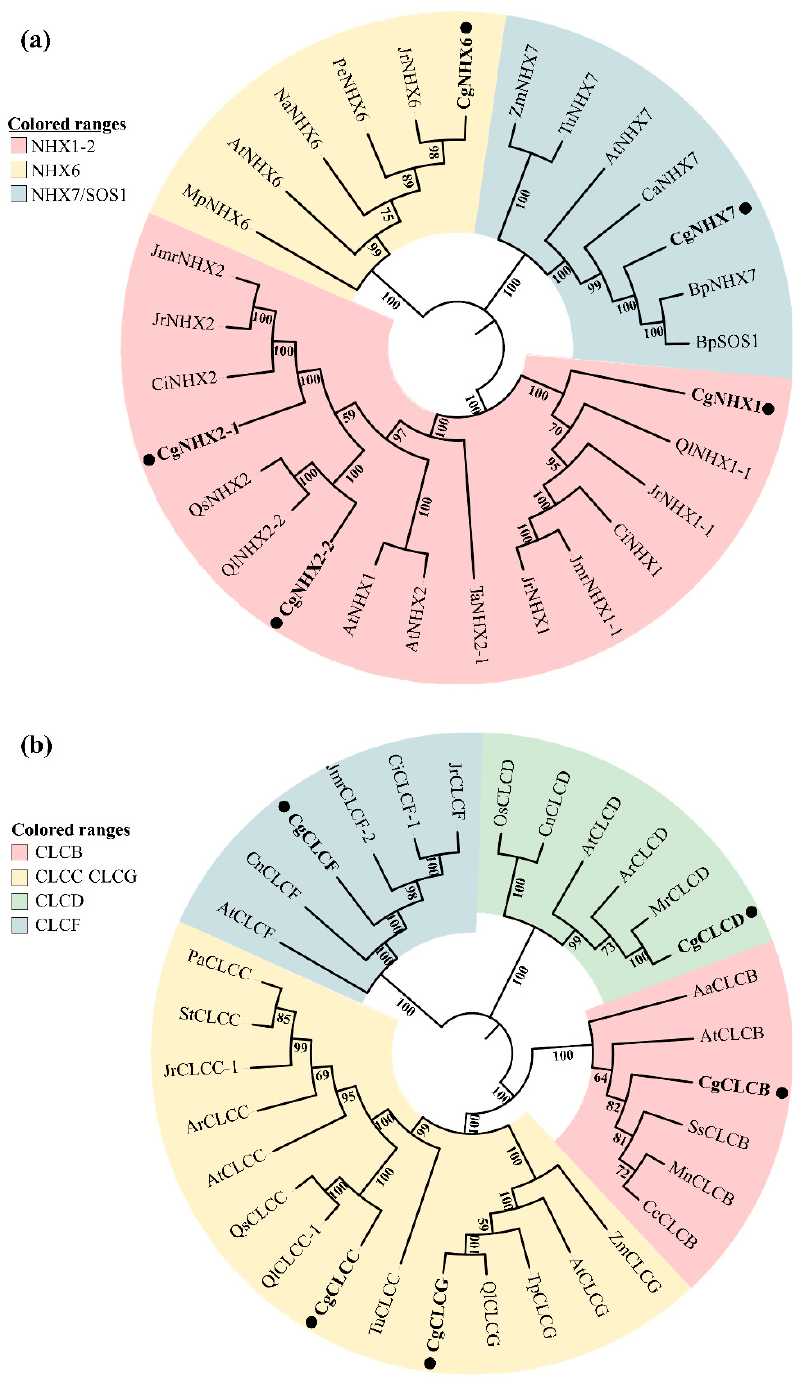
Figure 4. Phylogenetic tree of NHX and CLC protein translated from cloned genes. ( a ) Phylogenetic tree of NHX protein. ( b ) Phylogenetic tree of CLC protein. The genes marked by black dots are the target genes of the study. The NCBI number of the cloned gene is as follows: ON246321 ( CgNHX1 ), ON246322 ( CgNHX2-1 ), ON246323 ( CgNHX2-2 ), ON246324 ( CgNHX6 ), ON246325 ( CgNHX7 ),